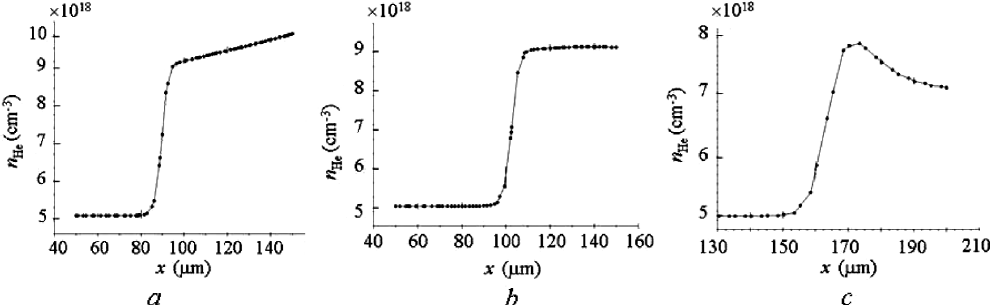
FIG. 4. The density distribution along the x direction through points a ( x , y ¼ 250 ), b ( x , y ¼ 150 ), and c ( x , y ¼ 50 ) of Fig. 3,